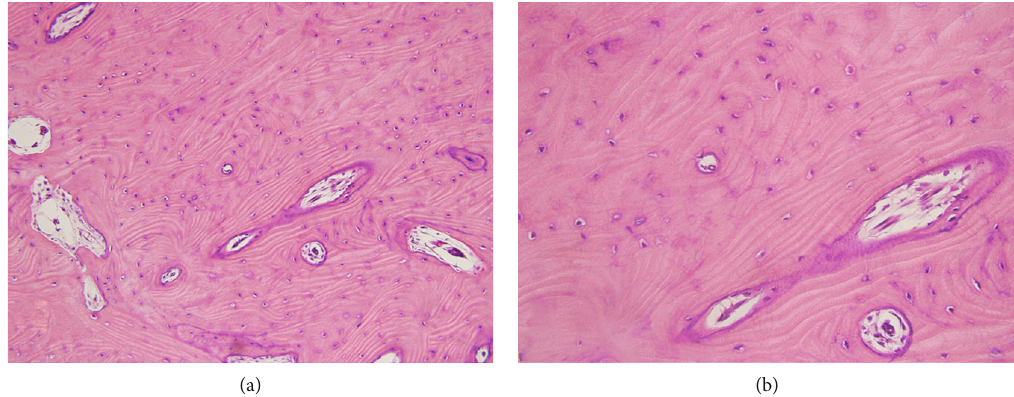
Figure 5: The histopathology of the peripheral osteoma. (a) Microscopic features of peripheral osteoma (hematoxylin-eosin, original magni fi cation × 200). (b) Microscopic features of peripheral osteoma (hematoxylin-eosin, original magni fi cation ×